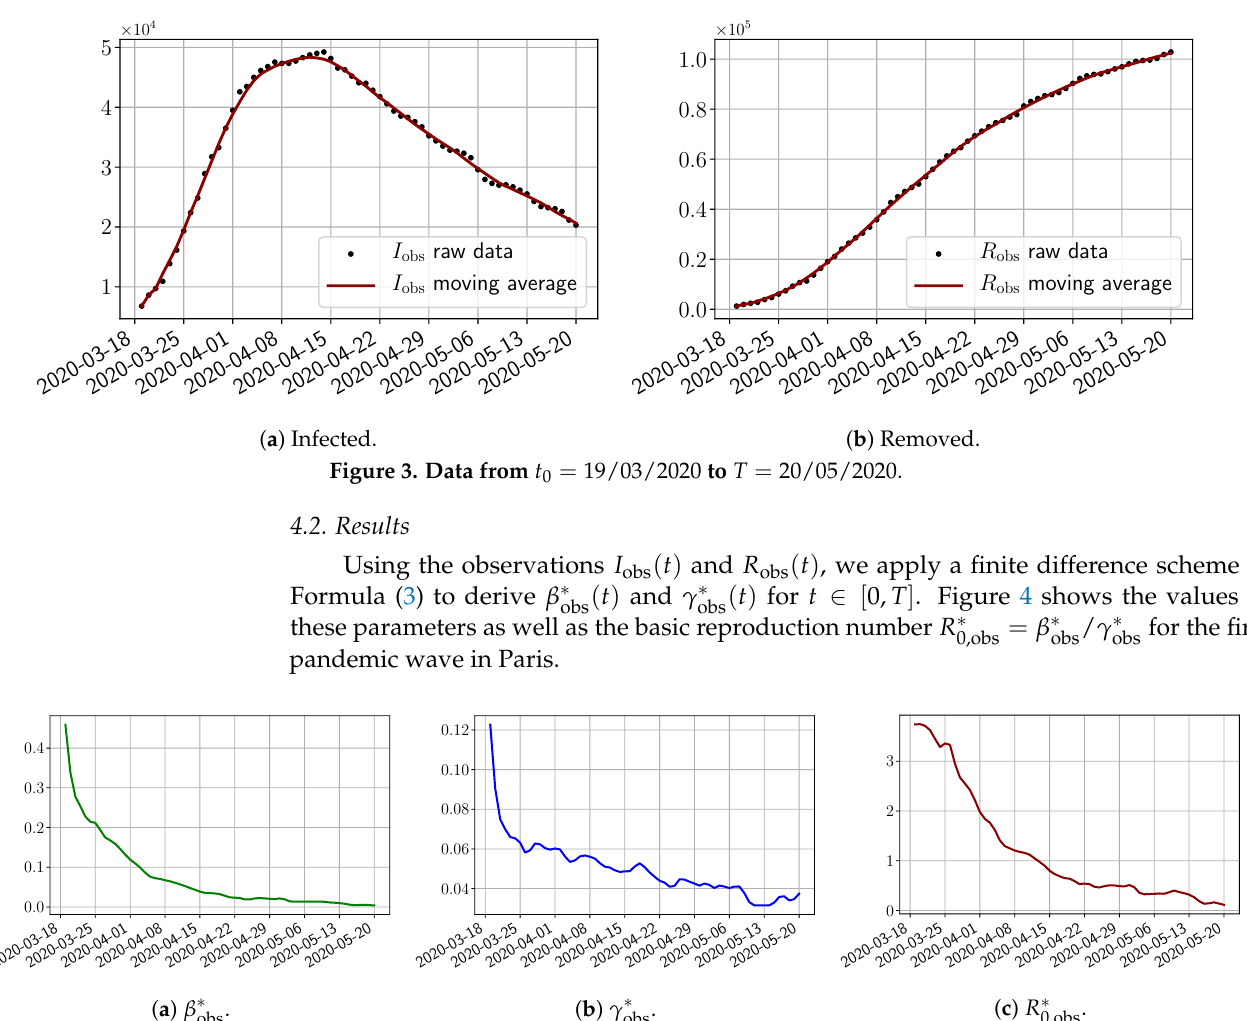
= β ∗ , γ ∗ , R ∗ / γ ∗ deduced from the data from t 0 = 19/03/2020 to T = 20/05/2020 obs obs 0,obs obs obs